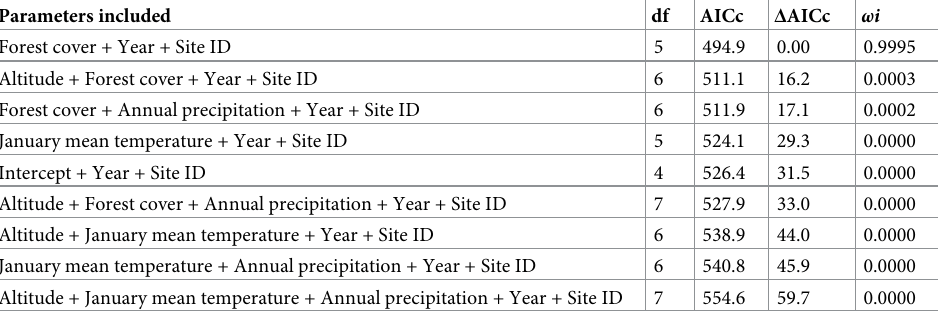
Table 1. Model selection (based on the AICc criteria) of considered multiple regression models aiming to investi- gate the effect of forest cover, mean January temperature, annual precipitation, and altitude on δ 13 C values in bone collagen of red deer from different sampling sites in